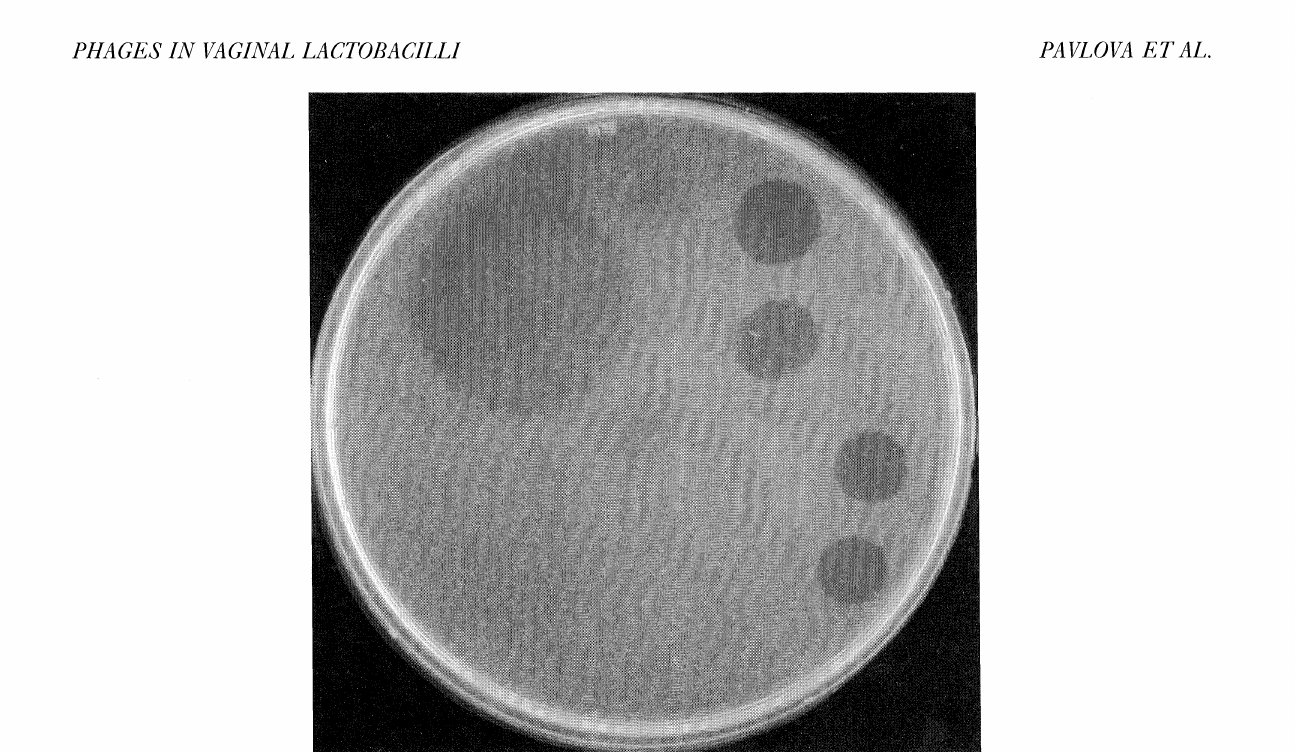
Fig. I. Lactobacillus phage infections on a soft agar plate. The larger circle of bacteriolysis on the left was cause by a drop of I1 of bkc005. The four smaller circles of bacteriolysis on the right were caused by drops of lal each of dkc012. The indicator strain was L. delbrueckii subsp, lactis ATCC 15808. Normally, the lysis of Lactobacillus cells would stop after 2 days of phage infection, with a lysis zone similar to the four smaller zones caused by dkc012. However, the infection of bkc005 continued as shown by the enlargement of the lytic zone with time. The result on this plate was 7 days after infection.